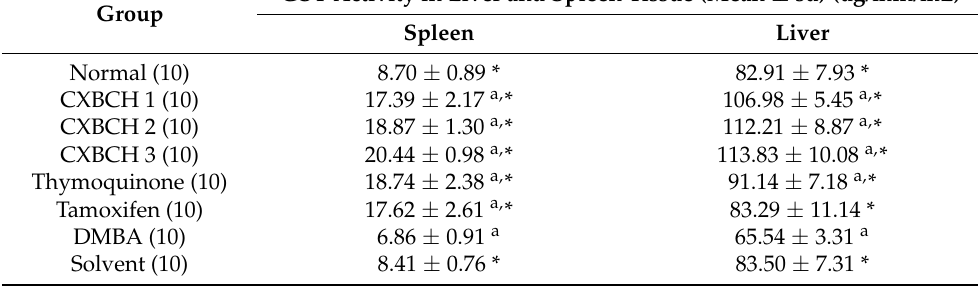
Table 7. GST activity of the liver and spleen of SD rats that received CXBCH two weeks before and five weeks during DMBA induction at week